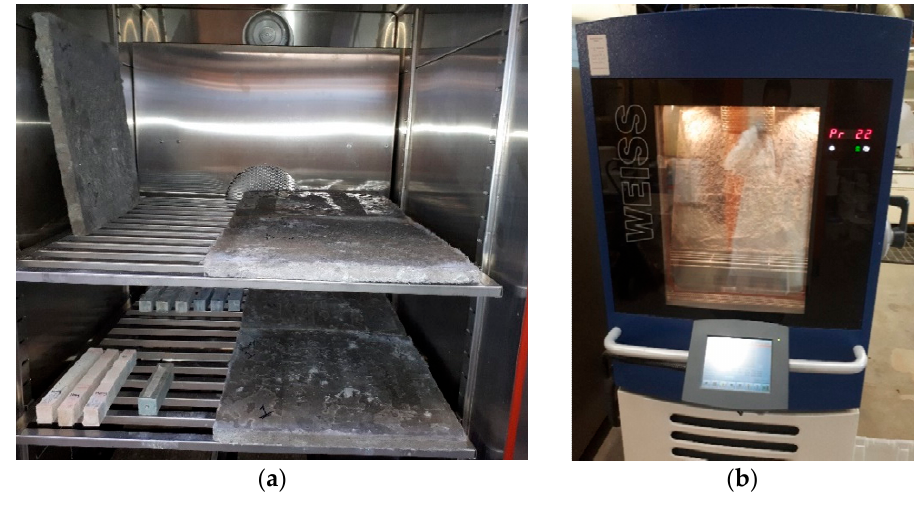
Figure 4. ( a ) Carbonation chamber; ( b ) freeze/thaw test.